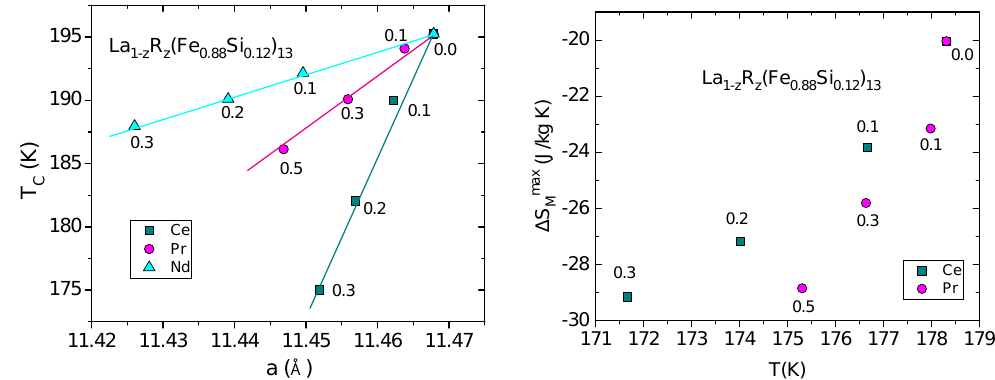
Figure 7. ( Left ) Evolution of T C vs. unit cell parameter, ( Right ) ∆ S max (R = Ce, Pr, Nd)